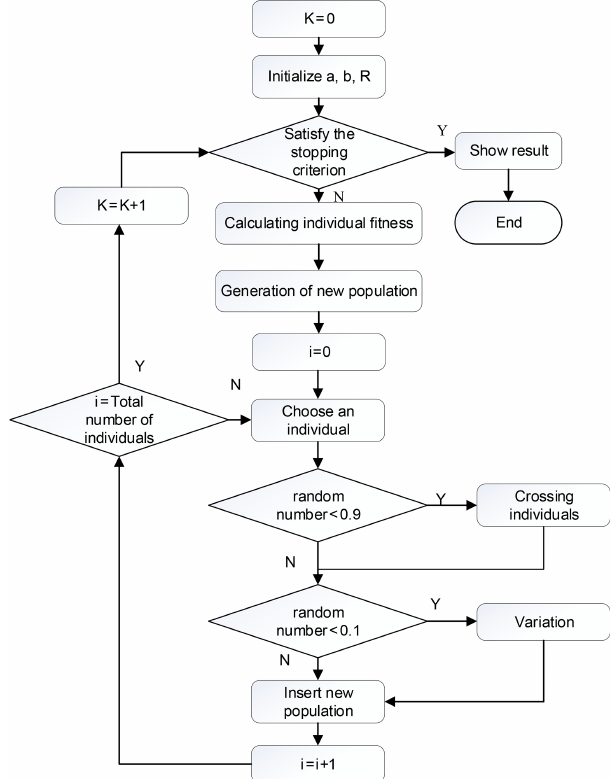
Figure 7. Genetic algorithm principle flow